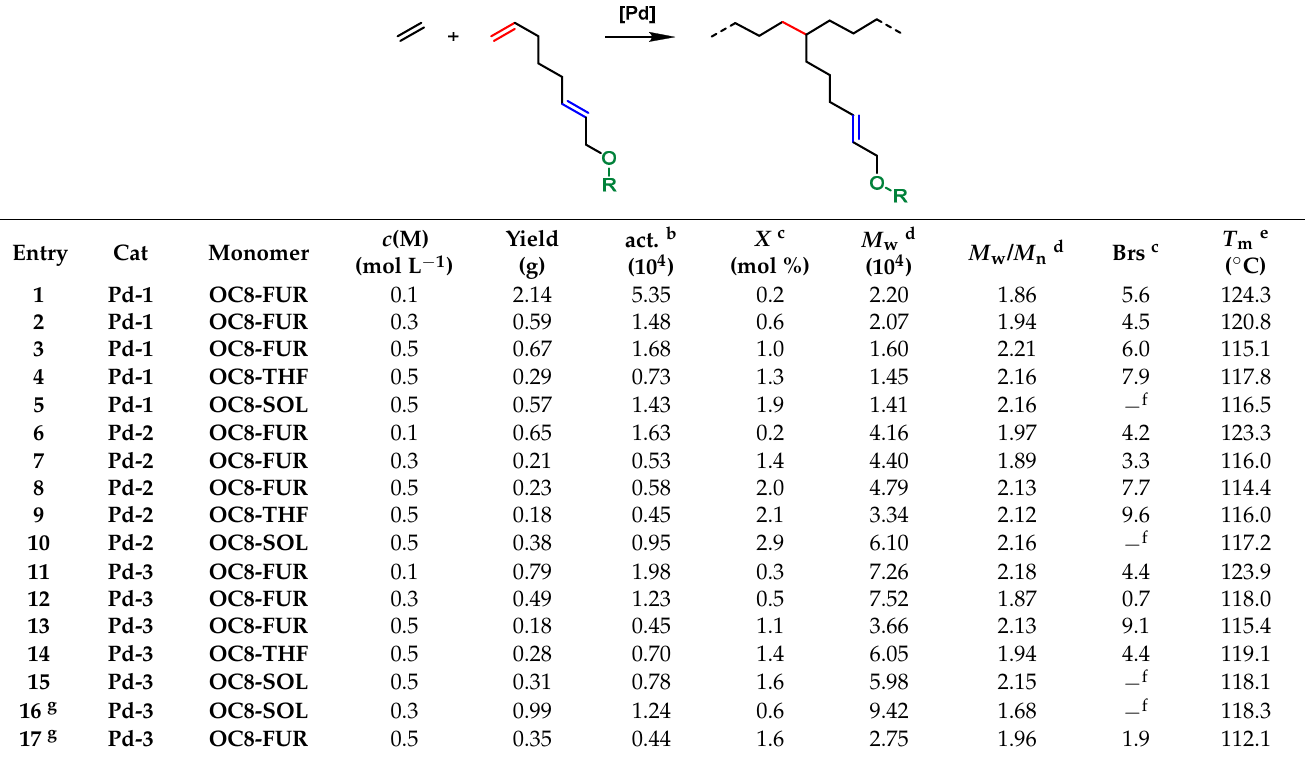
Table 1. Copolymerization of Ethylene and Bio-derived 2,7-Octadienyl Ether Monomers a .